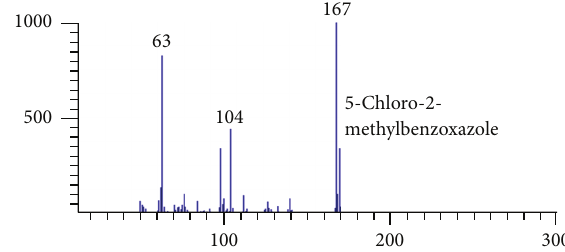
Figure 5: Mass spectrum of the decolorized product of 4-chloro-2- nitrophenol by Bacillus aryabhattai strain